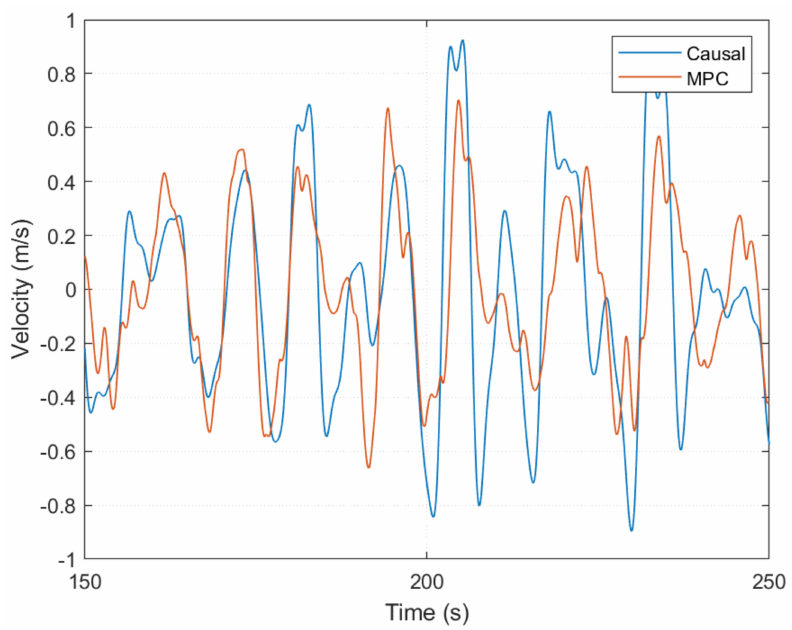
Figure 19. Time domain response comparison of WEC velocity with PTO force limit = 0.5 MN. Significant wave height Hs = 1.0 m, peak period Tp = 16